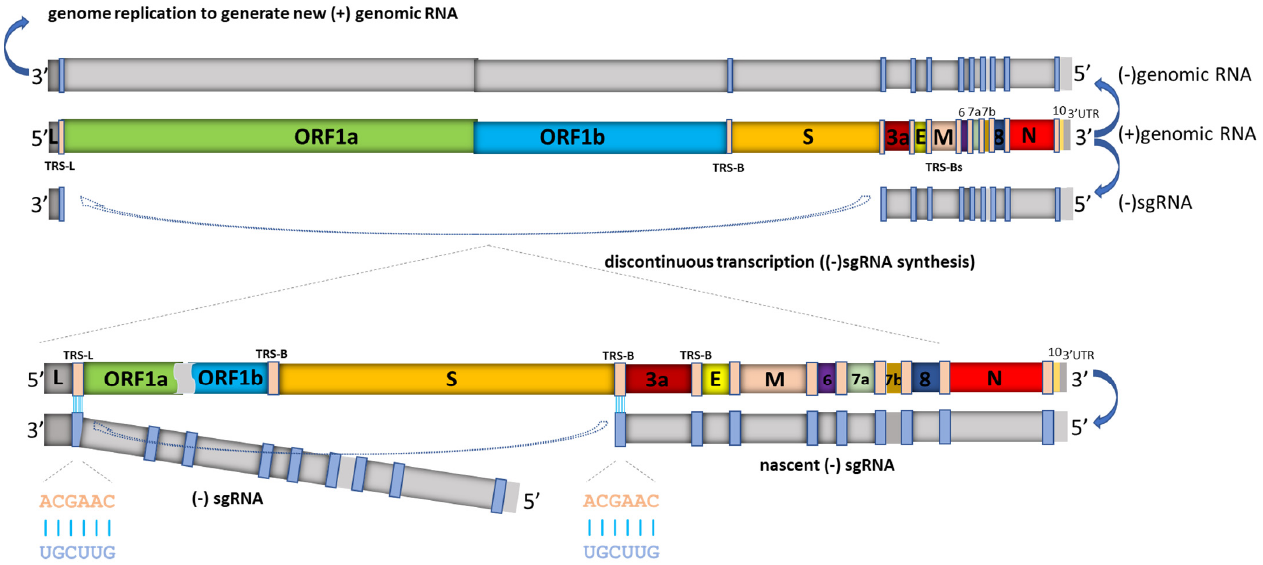
Figure 2. Schematic depiction of SARS-CoV-2 replication and discontinuous transcription. In addition to serving as a template for producing ( − ) genomic RNA (which enables genome replication), the full length (+) genomic RNA also serves as a template to produce ( − ) subgenomic RNAs (sgRNAs), which are subsequently used to synthesize (+) subgenomic mRNAs encoding structural and accessory proteins. ( − ) sgRNA synthesis involves a template switch from a body transcription regulatory sequence (TRS-B) (located upstream of most open reading frames in the 3 ′ one-third of the viral genome) to the leader TRS (TRS-L, located at about 70 nucleotides from the 5 ′ end of the genome). This discontinuous transcription process, leading to leader-body fusion, can occur at any TRS-B, and eventually results in the synthesis of a characteristic nested set of (+) subgenomic mRNAs. SARS-CoV-2 subgenomic mRNAs are structurally polycistronic, but are assumed to be functionally monocistronic [3,13], in that only the first open reading frame in each sgRNA, which is absent in the